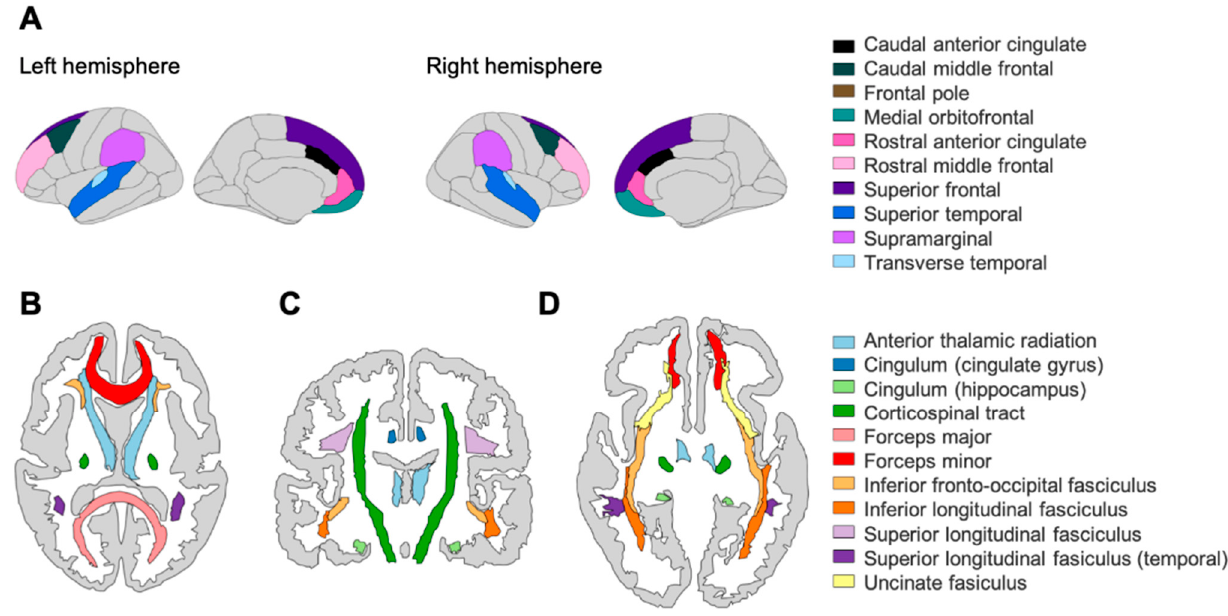
Figure 1. ( A ) Grey matter ROIs based on the Desikan–Killiany atlas (cortical volume, N = 246) in the left and right hemisphere. White matter ROIs based on the John’s Hopkin’s University atlas (fractional anisotropy, N = 165) in ( B ) transverse plane (superior), ( C ) coronal plane, and ( D ) transverse plane (inferior). Note that the frontal pole is not visible in these planes.